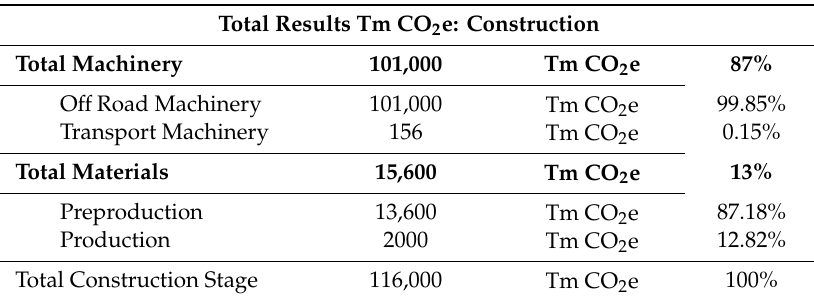
Table 5. Total CO 2 e results obtained in the construction phase.